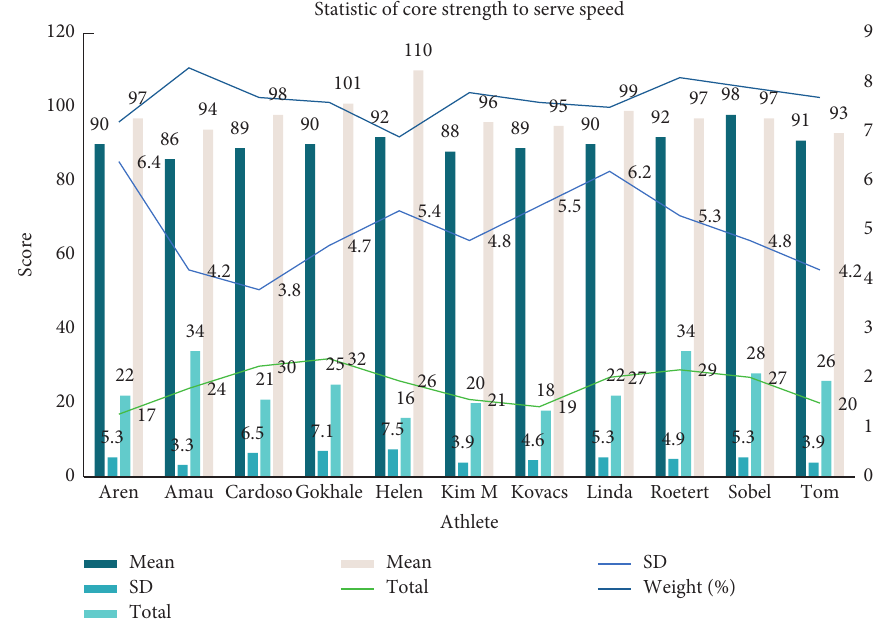
Figure 5: Statistics of core strength to serve speed. Table 2: Strength test index